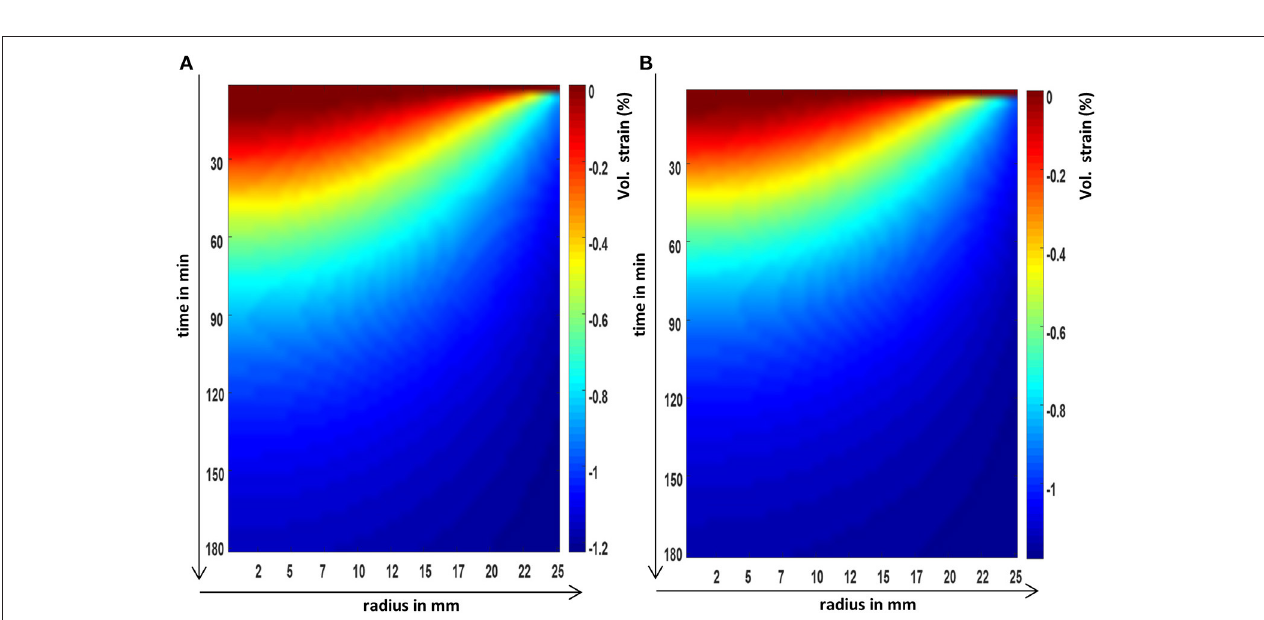
FIGURE 6 | The FEM predictions of the evolution of the volumetric strain or dilatation over time, at the axial center, and across the radius of a cylindrical poroelastic sample subjected to a constant axial stress (A) and an equivalent constant axial strain (B) .